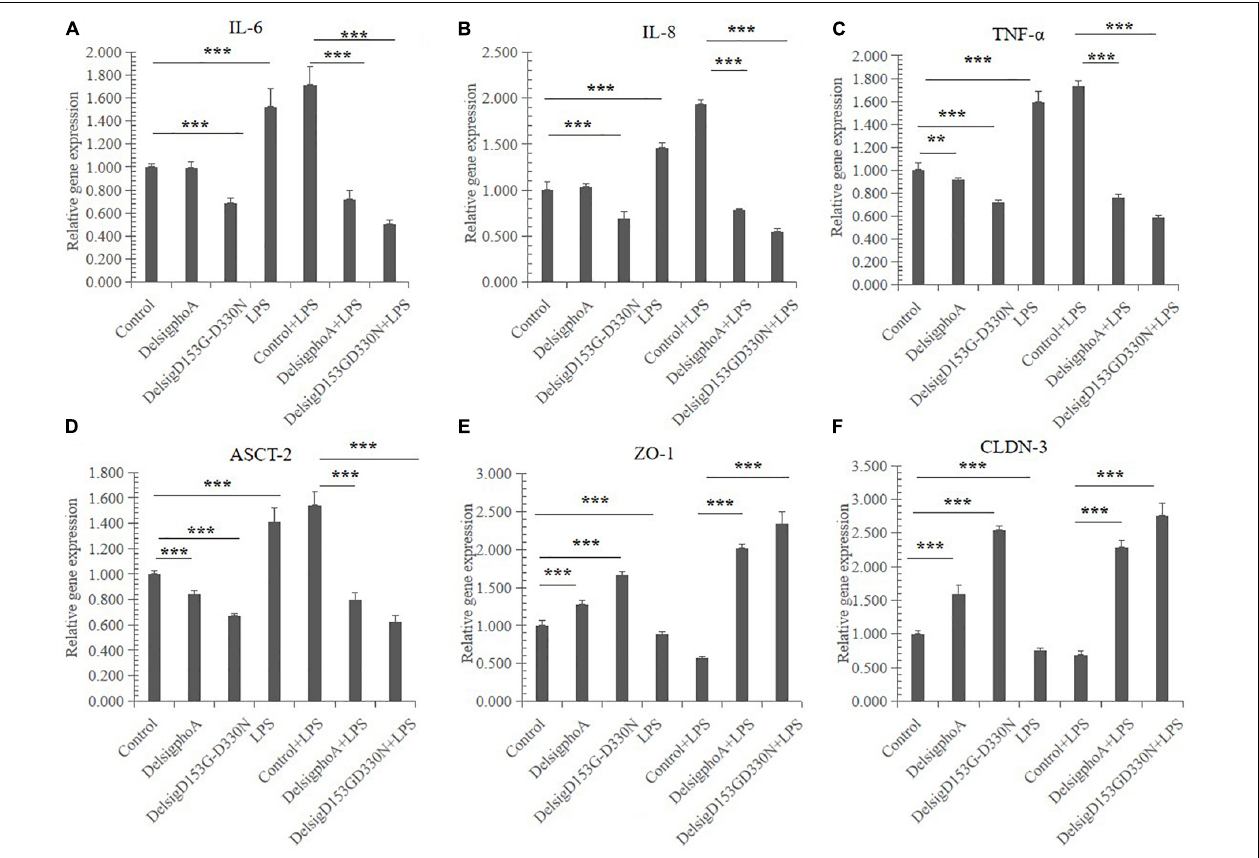
FIGURE 4 | The effect of AKP on relative mRNA abundances in LPS-induced IPEC-J2 cells. (A) The effect of AKP on relative mRNA abundances of interleukin 6 in LPS-induced IPEC-J2 cells. (B) The effect of AKP on relative mRNA abundances of interleukin 8 in LPS-induced IPEC-J2 cells. (C) The effect of AKP on relative mRNA abundances of tumor necrosis factor α in LPS-induced IPEC-J2 cells. (D) The effect of AKP on relative mRNA abundances of ASC amino acid transporter 2 in LPS-induced IPEC-J2 cells. (E) The effect of AKP on relative mRNA abundances of zonula occludens protein-1 in LPS-induced IPEC-J2 cells. (F) The effect of AKP on relative mRNA abundances of occludin-3 in LPS-induced IPEC-J2 cells. Error bars, SD; n = 10. **Significant ( p < 0.05), ***very significant ( p <